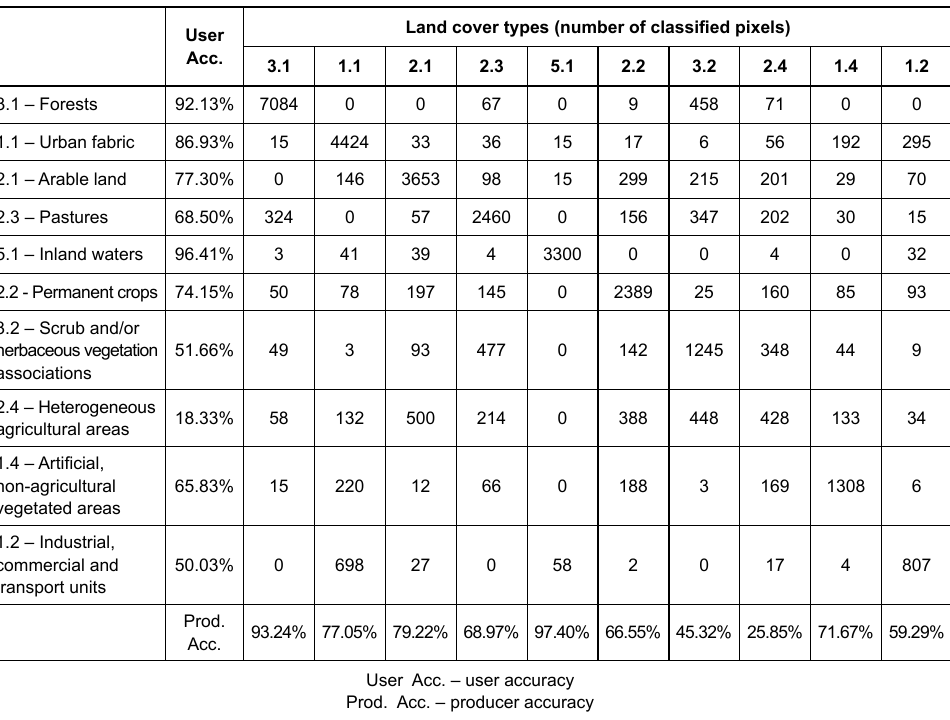
Tab. 2. Error matrix of the image classification acquired on 21 April 2011 User